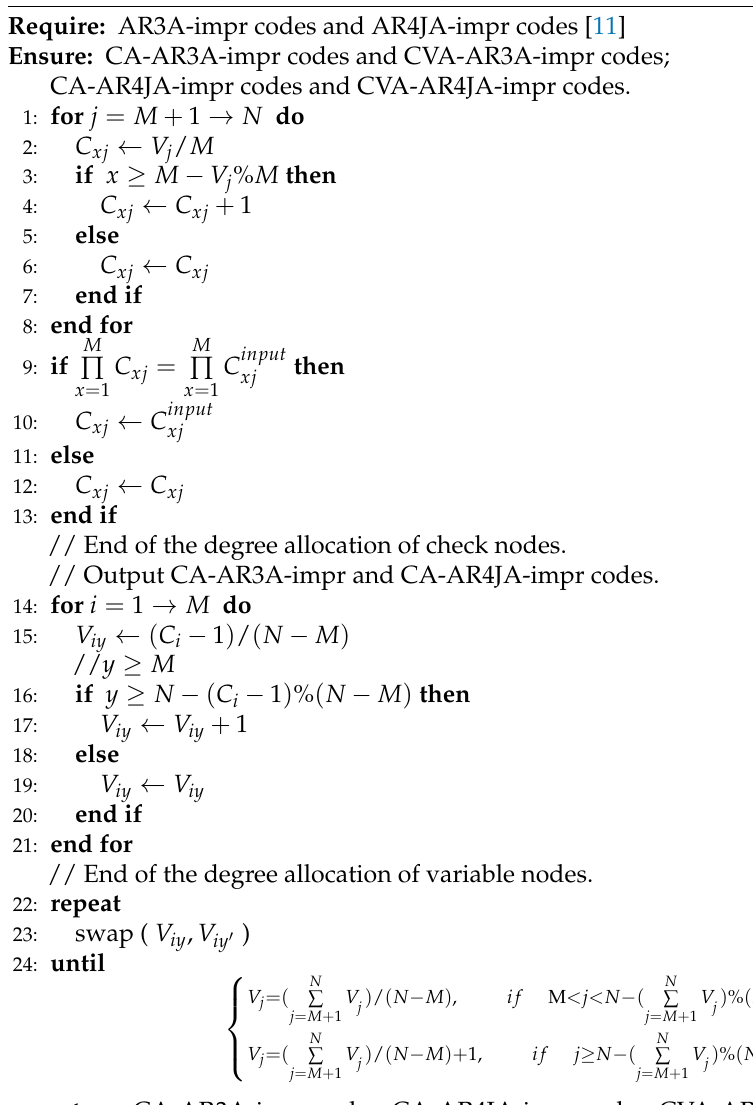
Algorithm 1 CA algorithm and CVA